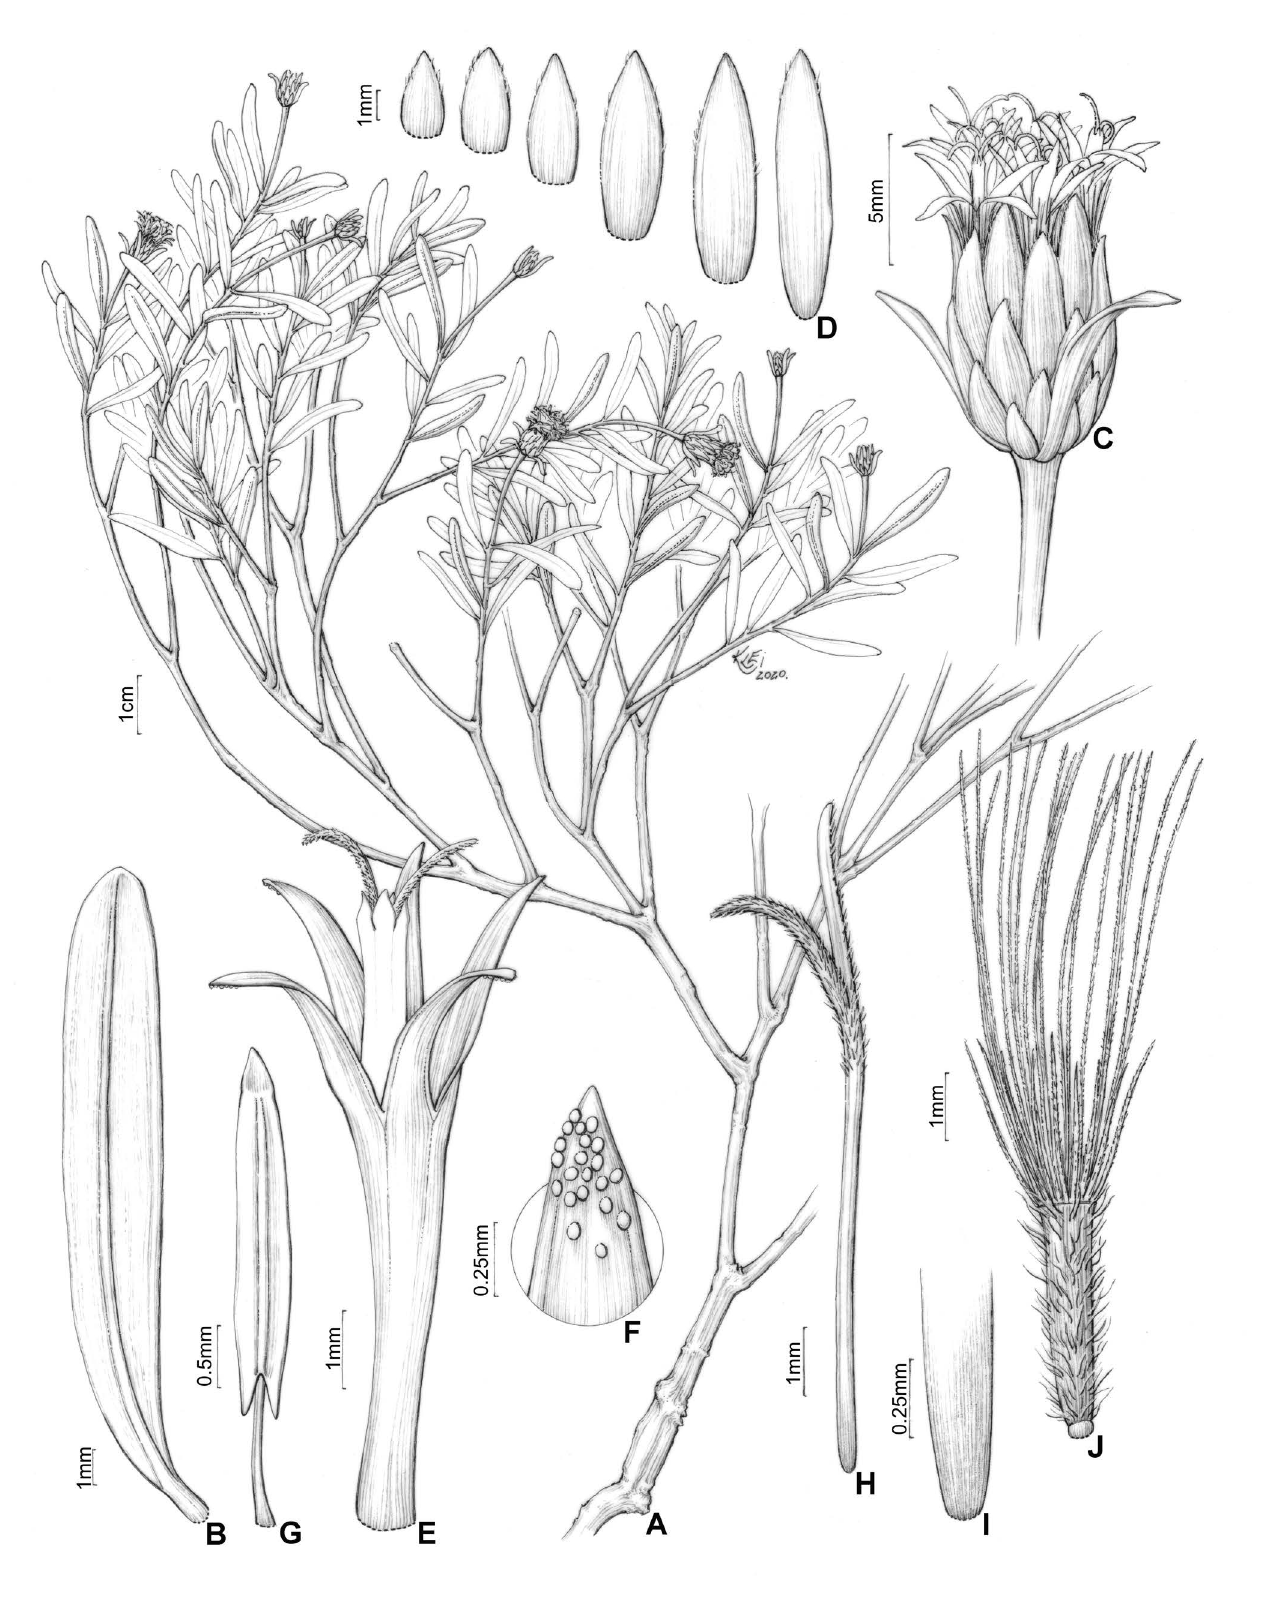
Figure 4 – Lessingianthus petraeus Antar & Loeuille. A . Habit. B . Leaf, abaxial surface. C . Capitulum. D . Outer to inner involucral bracts. E . Corolla, stamens, and style. F . Corolla lobe apex. G . Stamen. H . Style. I . Style base. J . Cypsela with pappus. A–J from Loeuille et al. 901 (SPF). Illustration by Klei